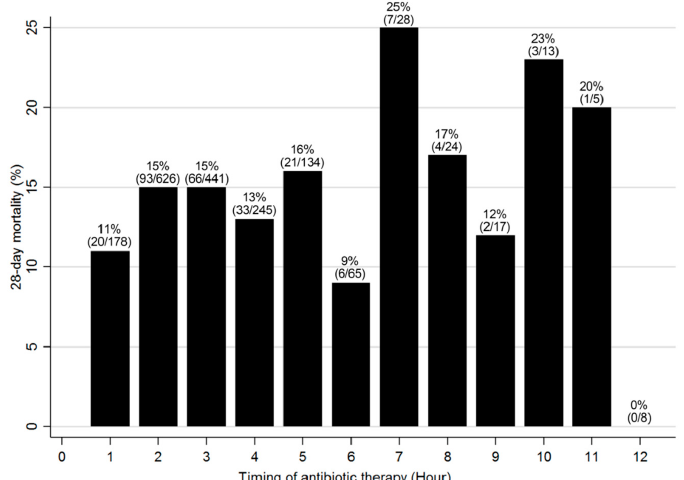
Figure 1. Crude 28-day mortality according to the timing of first antibiotic therapy. A total of 1784 patients were analyzed the crude mortality was 14%. The bars represent the proportions of patients who received their first antibiotic therapy within the indicated time period and died within 28 days after presentation to the emergency department. The number represents % (no./total no. of each group).